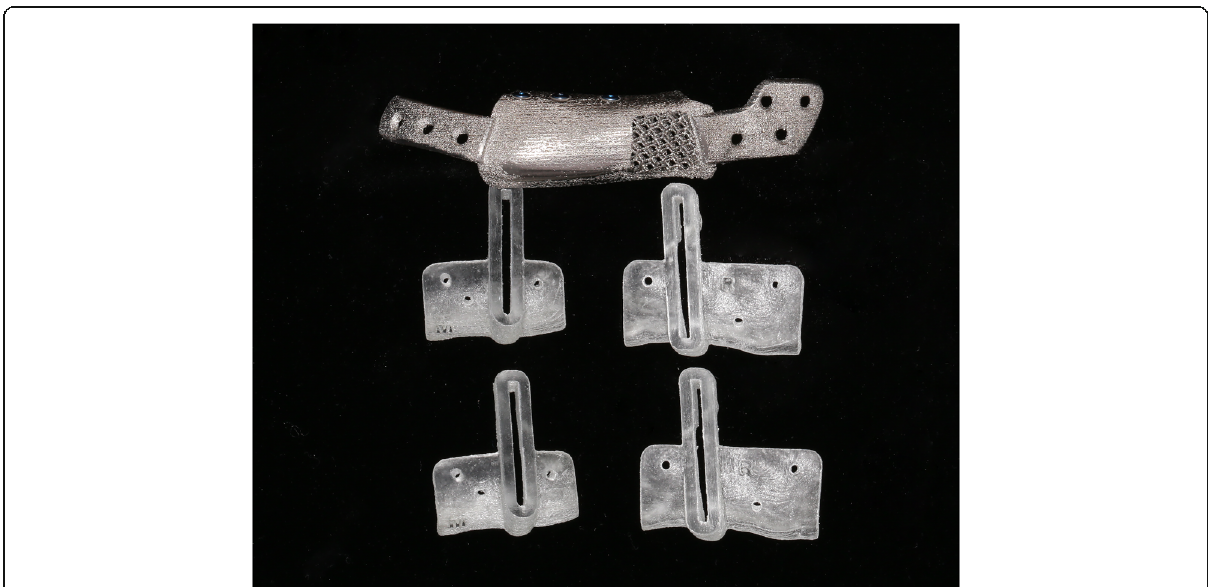
Fig. 2 3D-printed resection guide and titanium mandibular implant